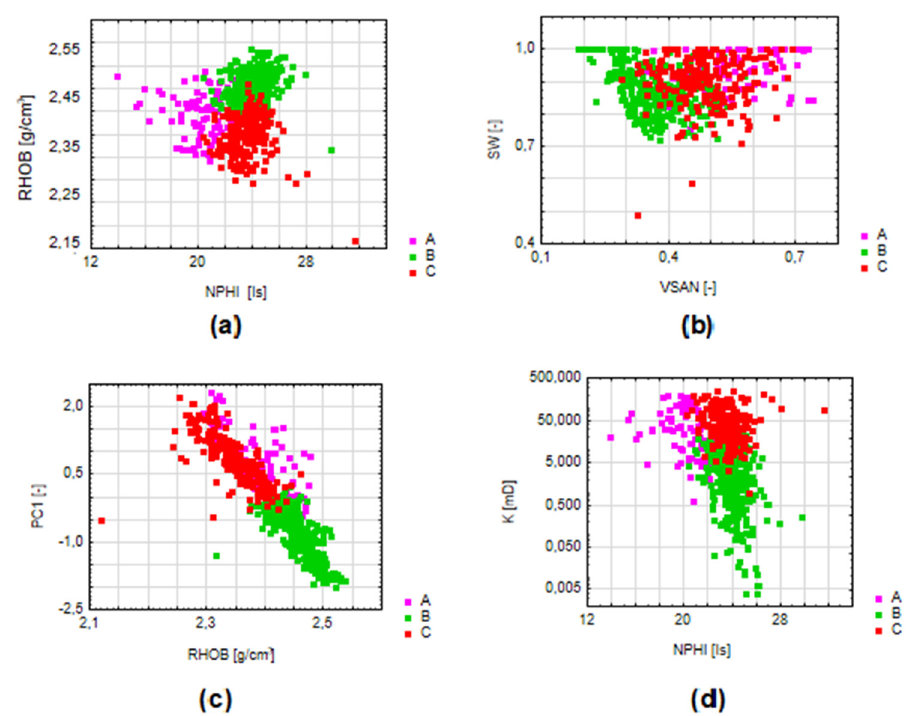
Figure 3. Clustering results (different colours on the graphs) in the relation to the standard well logs interpretation, W-2 well: ( a ) row data relation RHOB vs. NPHI; ( b ) volume of quartz mineral content VSAN in the relation to the water saturation SW; ( c ) bulk density RHOB in the relation to the PC1; ( d ) neutron porosity in the relation to the permeability.